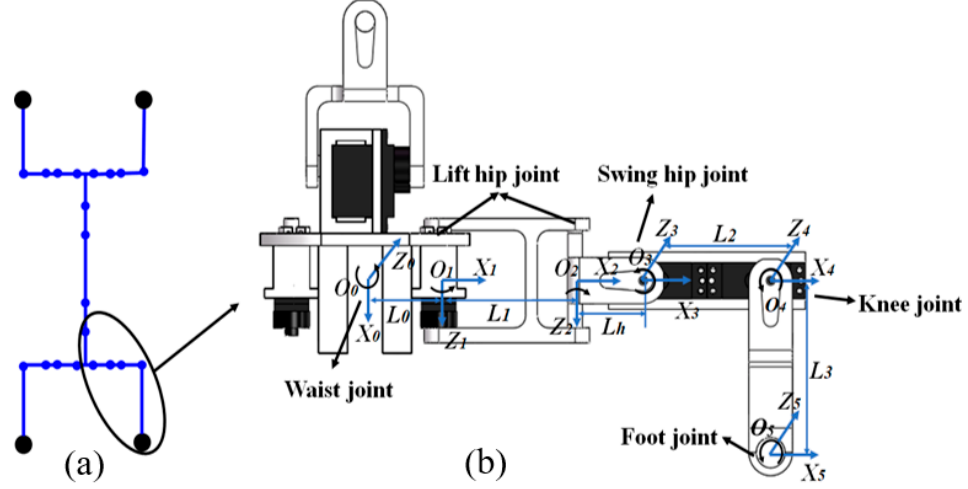
Figure 3. Leg motion analysis: ( a ) joints of the robot diagram and ( b ) coordination systems. Based on the coordinate system shown in Figure 3, the D–H parameters can be obtained as given in Table 1. By transformations of the pose matrix, the positions of each joint can be resolved as the claw [24]. Table 1. D–H parameter table. Link